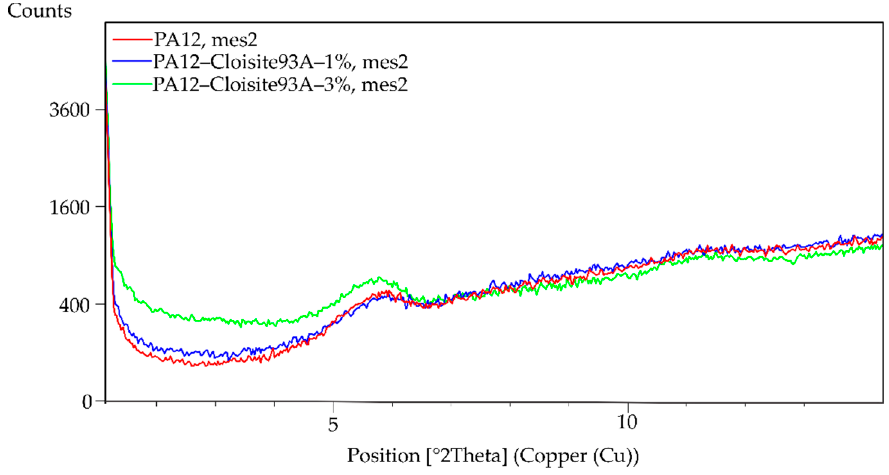
Figure 4. XRD graph (detail) of PA12, PA12/1% of Cloisite 93A and PA12/3% of Cloisite 93A. TEM pictures of neat PA12 and PA12 nanocomposites are presented in Figure 5. Figure 5a represents neat PA12. It was apparent that the structure was homogeneous in this case.